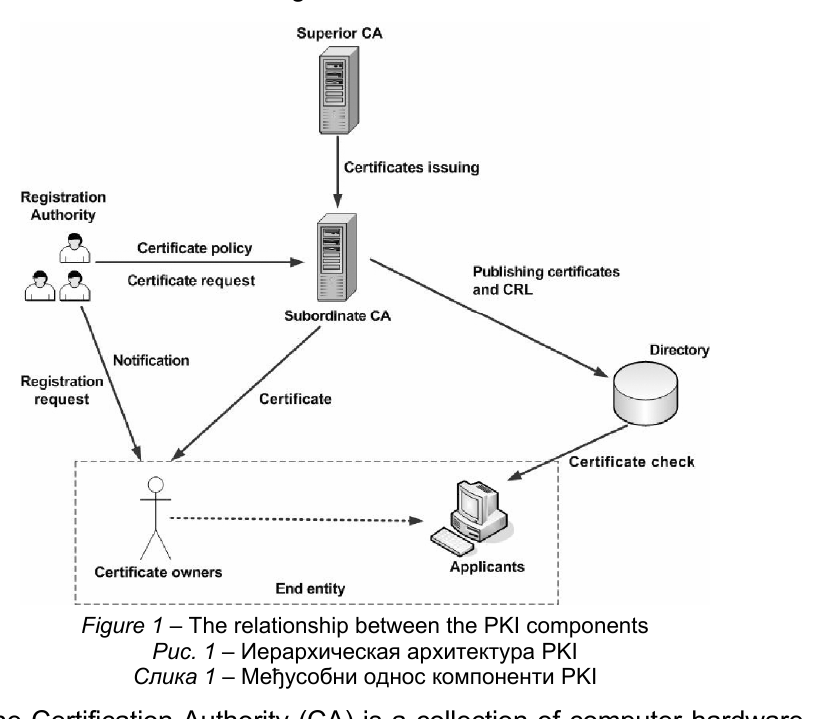
Figure 1 – The relationship between the PKI components Рис . 1 – Иерархическая архитектура